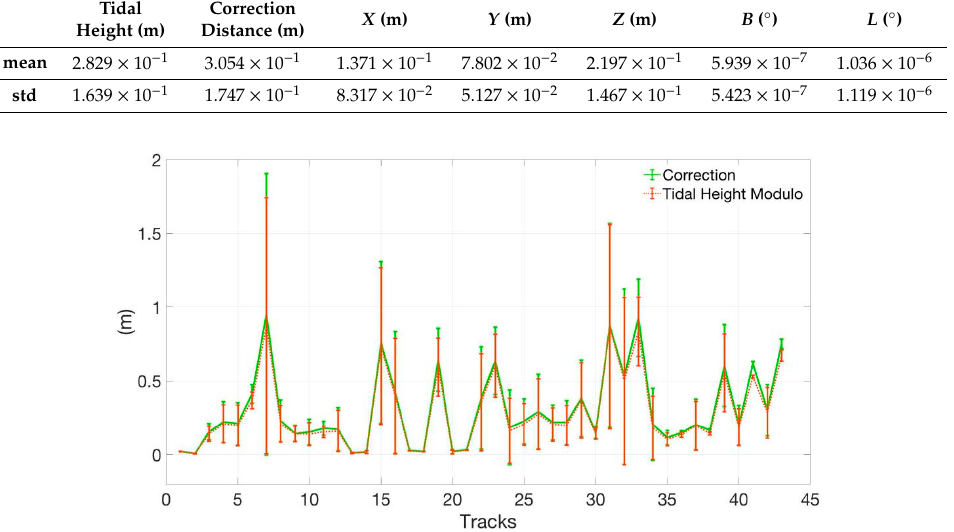
Figure 3. Tidal height modulos and the corresponding tidal positioning corrections of the tracks.